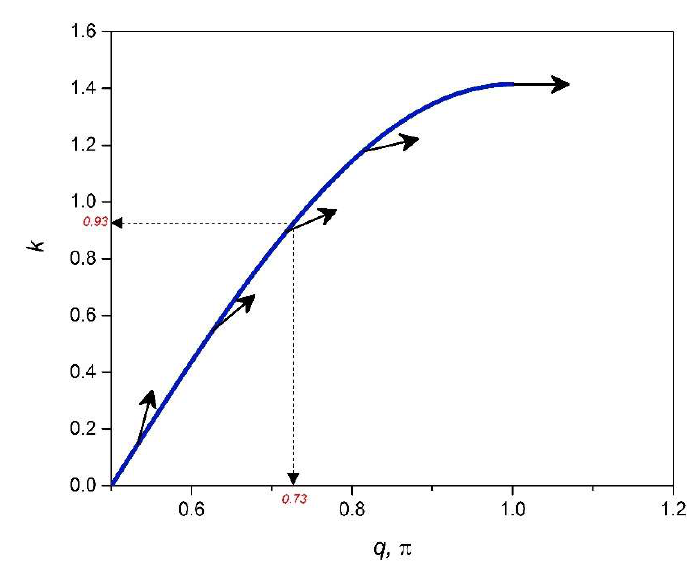
Figure 2. Occurrence of zero eigenvalues in the ( q , k )-parameter space of Figure 1 lattice. Arrows represent the orientation of their corresponding polarization vectors, h ( q ).